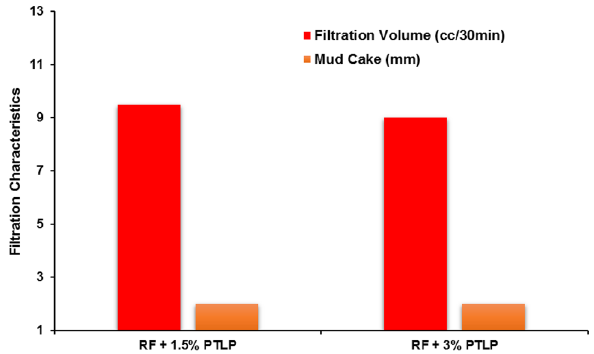
Fig. 7 The influence of PTLP on the filtration characteristics (aged conditions)